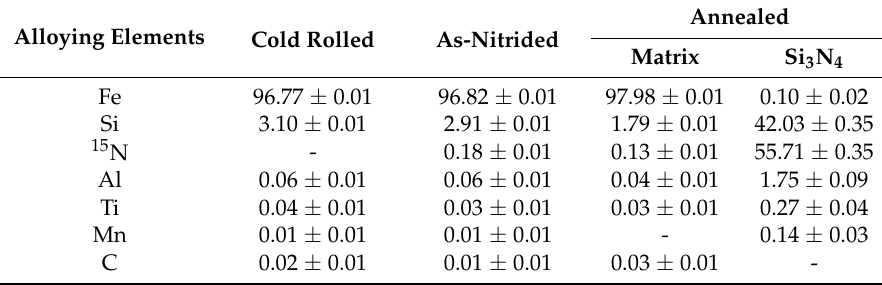
Table 1. Atomic compositions of the Fe–Si alloy, after cold rolling, nitriding, and annealing. Compositions in the annealed sample are given separately for the ferritic matrix and Si 3 N 4 precipitates. Al–N clusters are also excluded for the calculation of matrix composition. The error is calculated from counting statistics, according to [35].